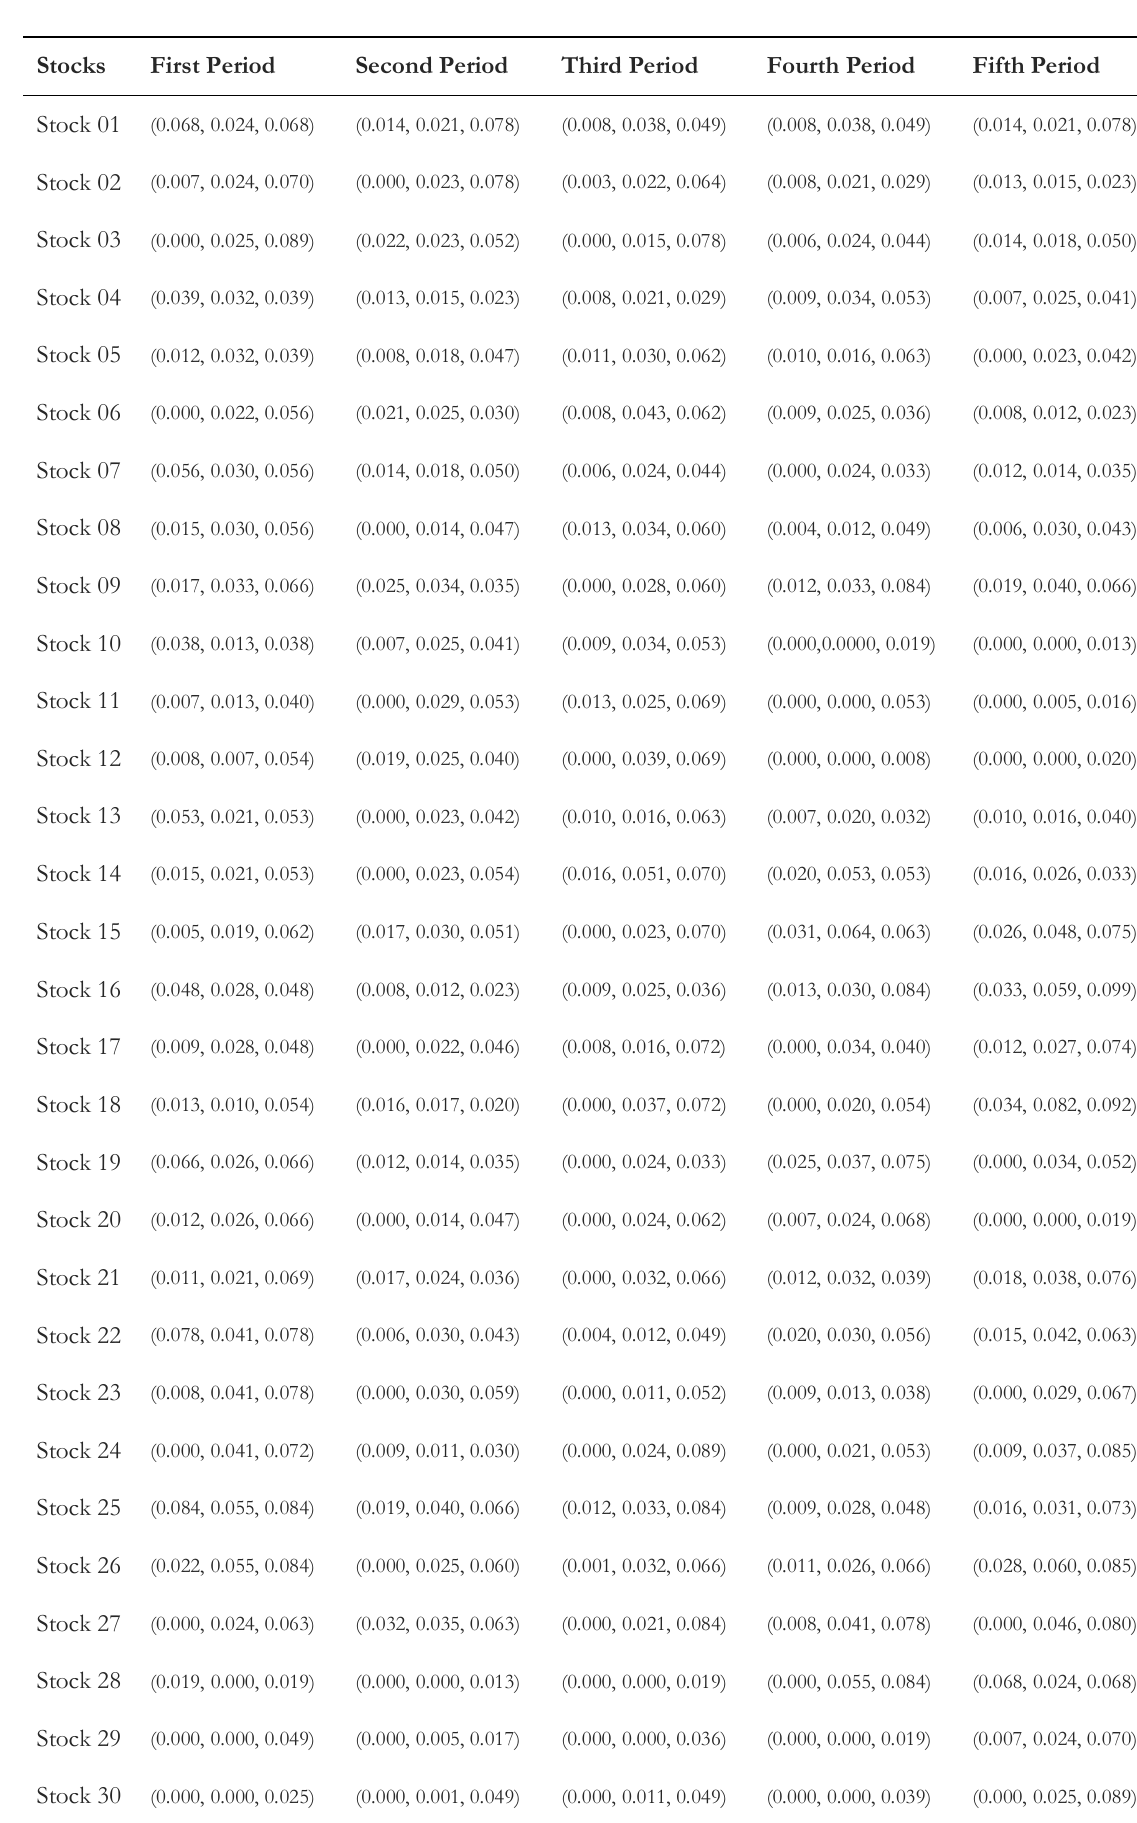
Table 2. Fuzzy data set for